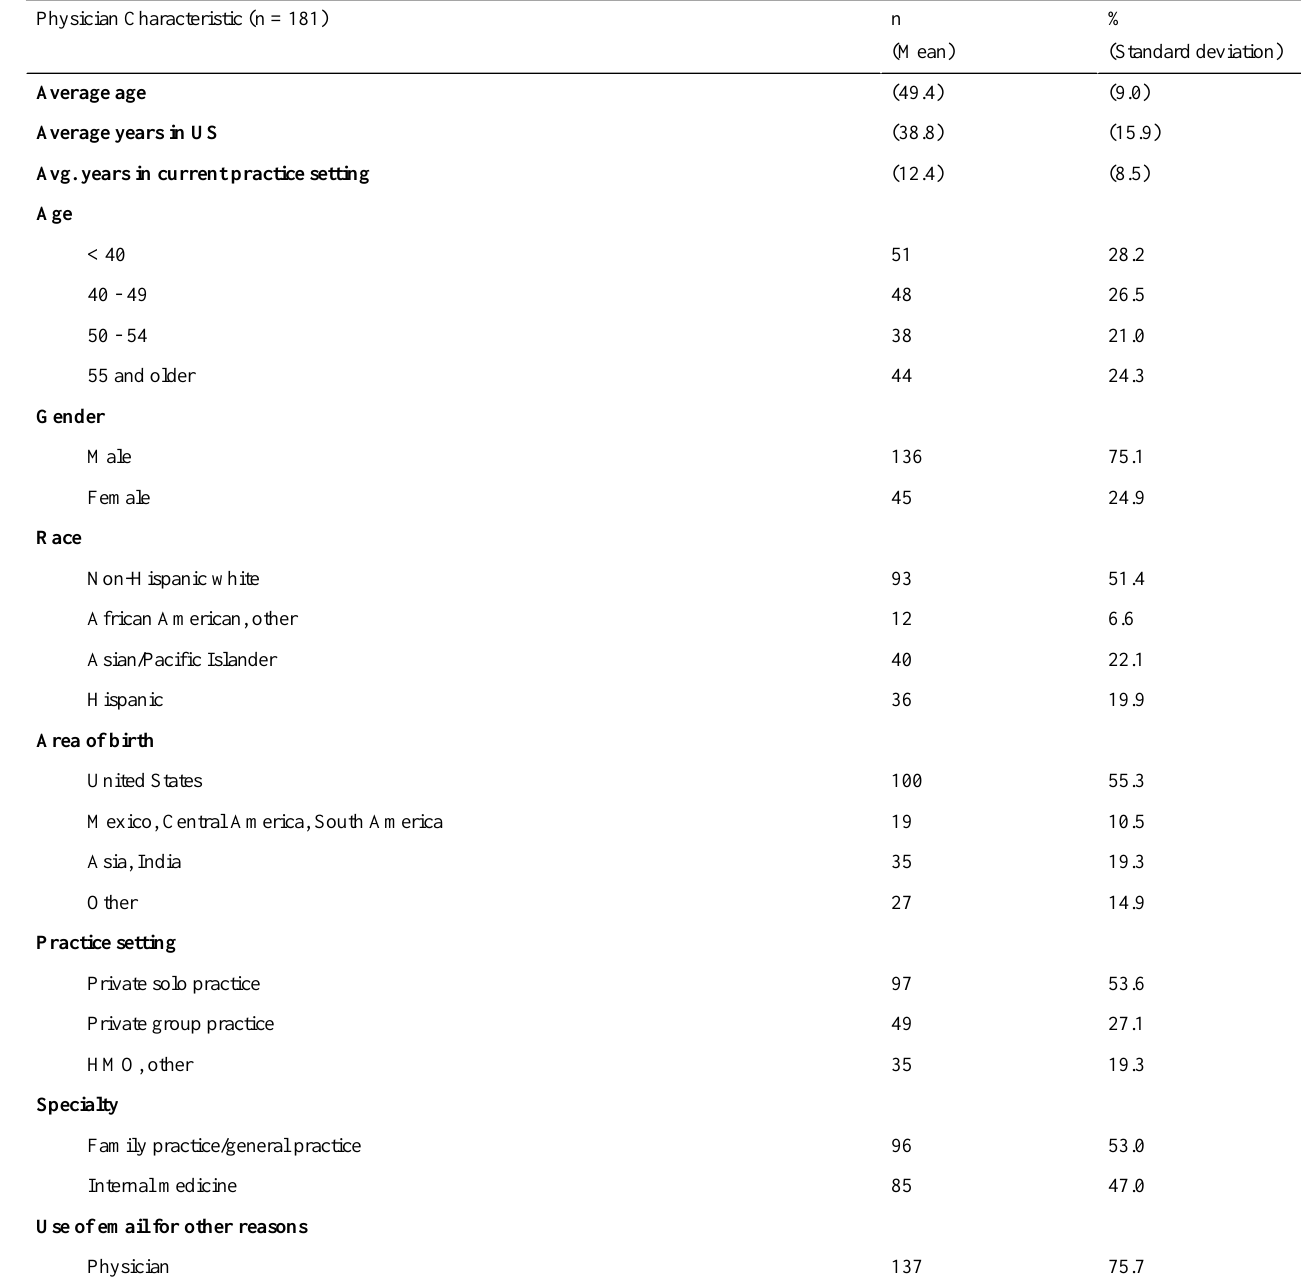
Table 3. Characteristics of 181 physicians in the pooled sample from the 2003 CMC 2 exit and 2003 CMC 3 baseline